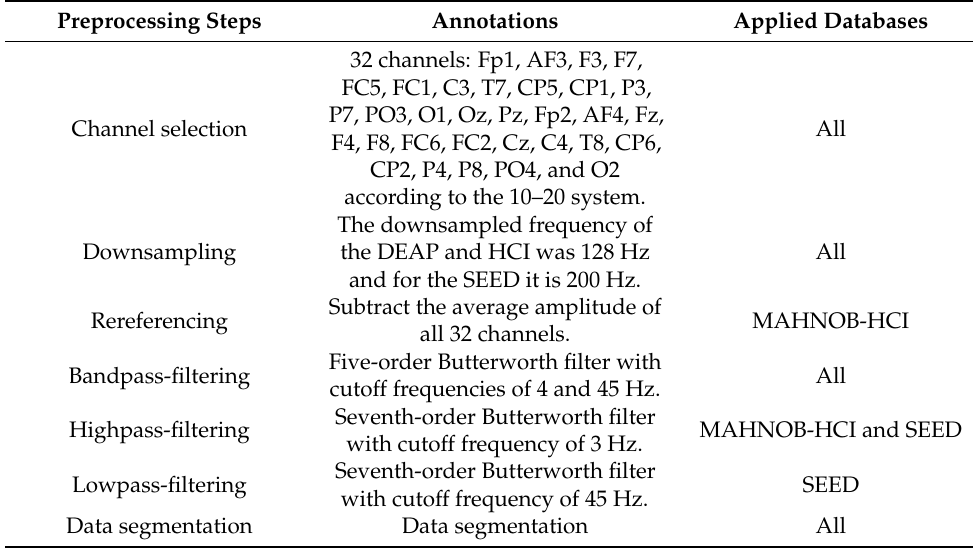
Table 1. Filter implementations for the EEG in three